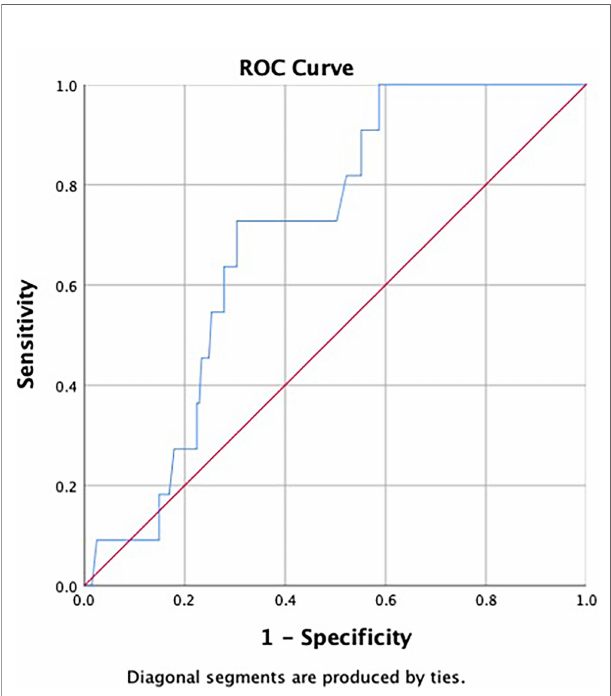
FIGURE 1 | Receiver operating characteristic (ROC) curve was used to assess discrimination power of ratio of platelet distribution width to platelet crit (PDW/PCT). The area under the curve (AUC) was